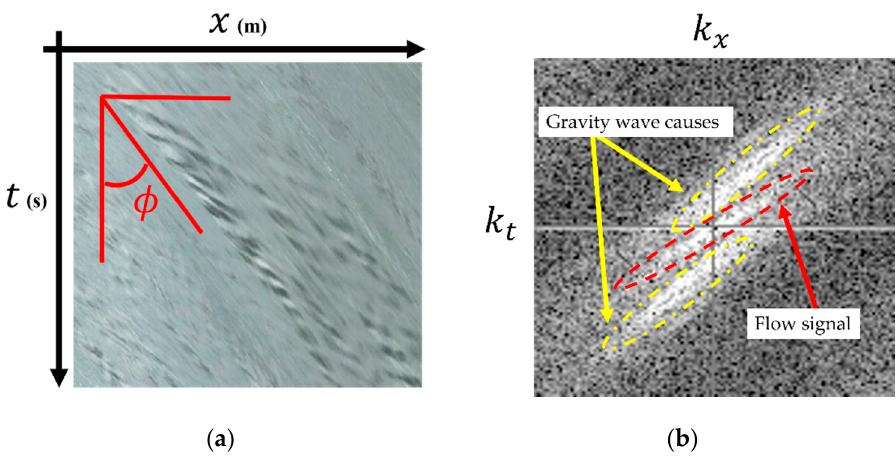
Figure 1. Original and orthorectified images with search lines: ( a ) original; ( b ) orthorectified im- age.